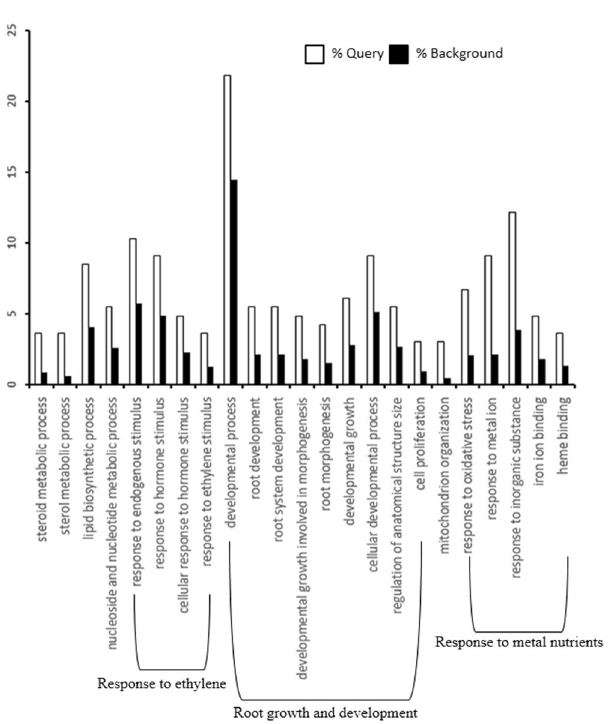
Figure 7. Singular Enrichment Analysis (SEA) for differentially expressed genes of root + shoot due to P 20 (20 mM) treatment. It shows the change in ethylene, root growth and development, and response to metal nutrients related processes. The analysis was performed using the agriGO analysis tool under advanced mode, Fisher test with P < 0.05 and minimum 5 mapping entries. The white bar shows the fraction of query genes, and the black bar shows a fraction of genes in background (whole